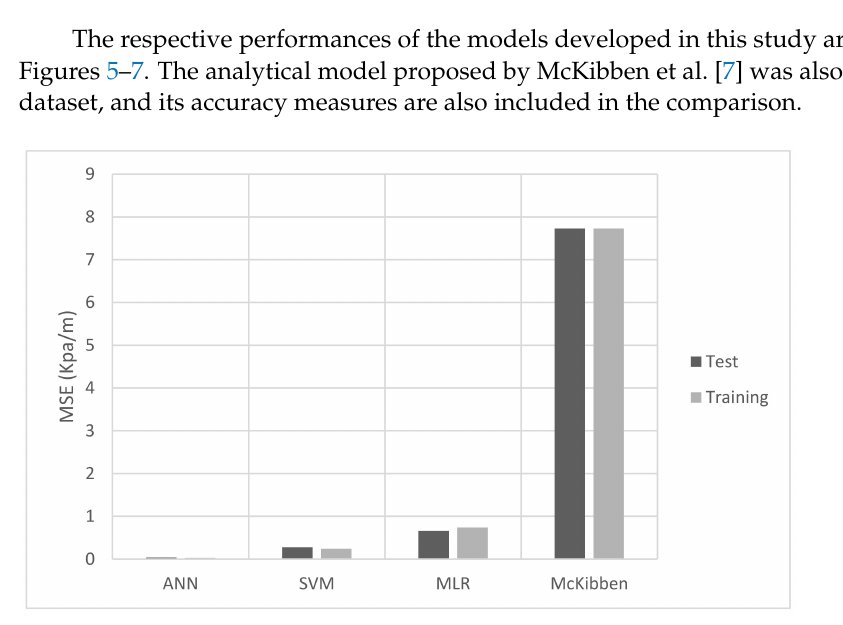
Figure 5. Comparison of